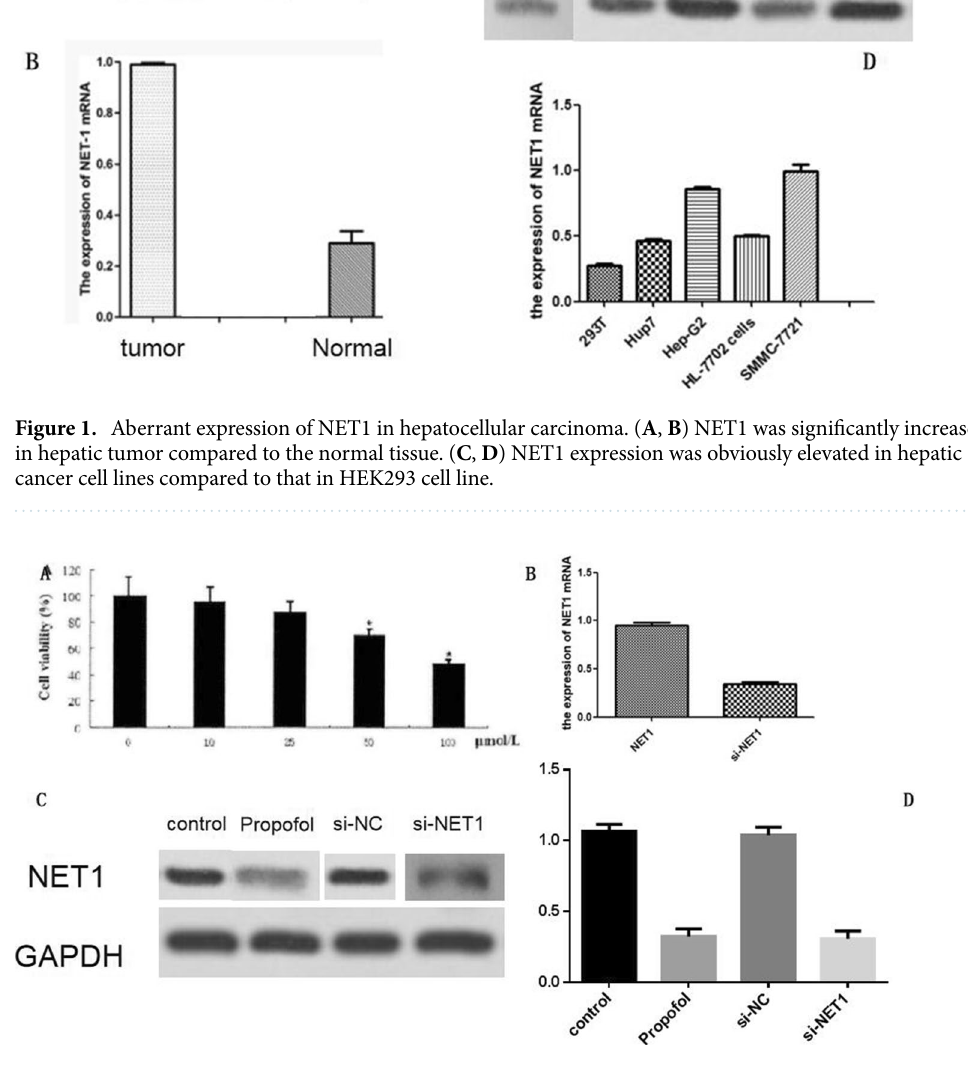
Figure 2. Propofol inhibited SMMC‑7721cell viability through regulating NET1 expression. ( A ) Cells treated with the indicated propofol at doses of 0, 10, 25, 50, 100 μM for 48 h exhibited decreased cell viability. ( B ) NET1 mRNA level was decreased by NET1‑siRNA. ( C , D ) NET1 protein level was decreased by propofol treatment and